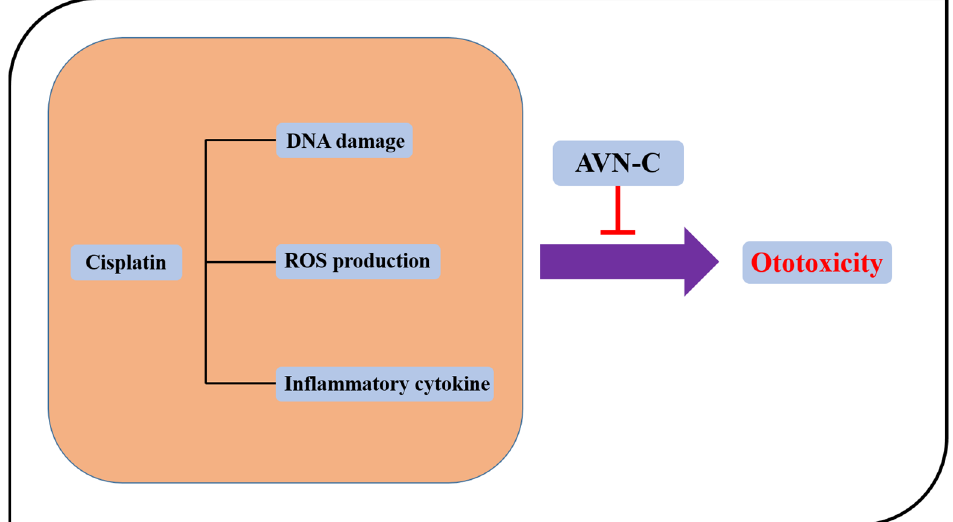
Figure 7. Proposed mechanism of action by AVN-C. CP damages DNA and induces the production of ROS and inflammation whereas AVN-C inhibits both ROS and inflammation and DNA-involved damage. Protects against is shown by the red icon below AVN-C.